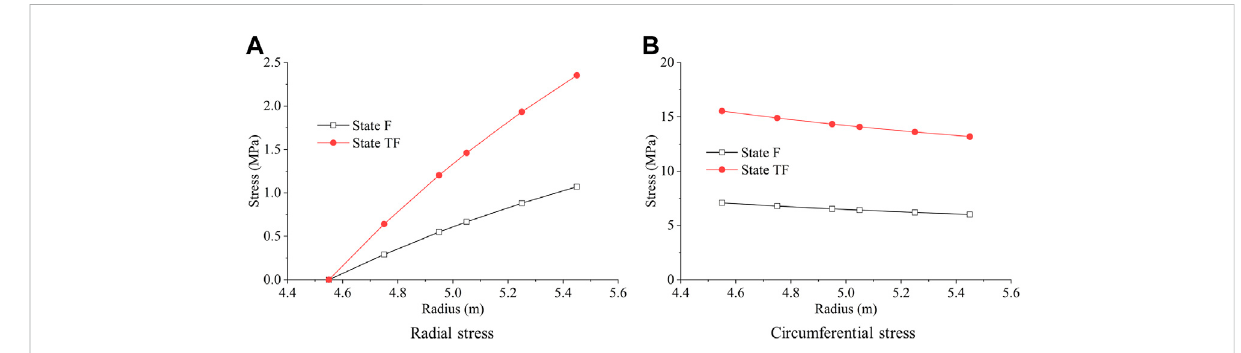
FIGURE 8 Stress of lining under state F and state TF.